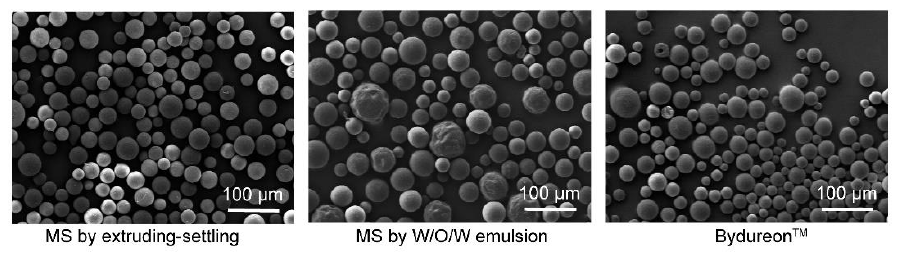
Figure 2. SEM images of microspheres produced by the present extruding–settling method, micro- spheres by W/O/W double emulsion and Bydureon TM . Table 1. Encapsulation efficiency of exenatide (means ± SD, n = 3). Formulation